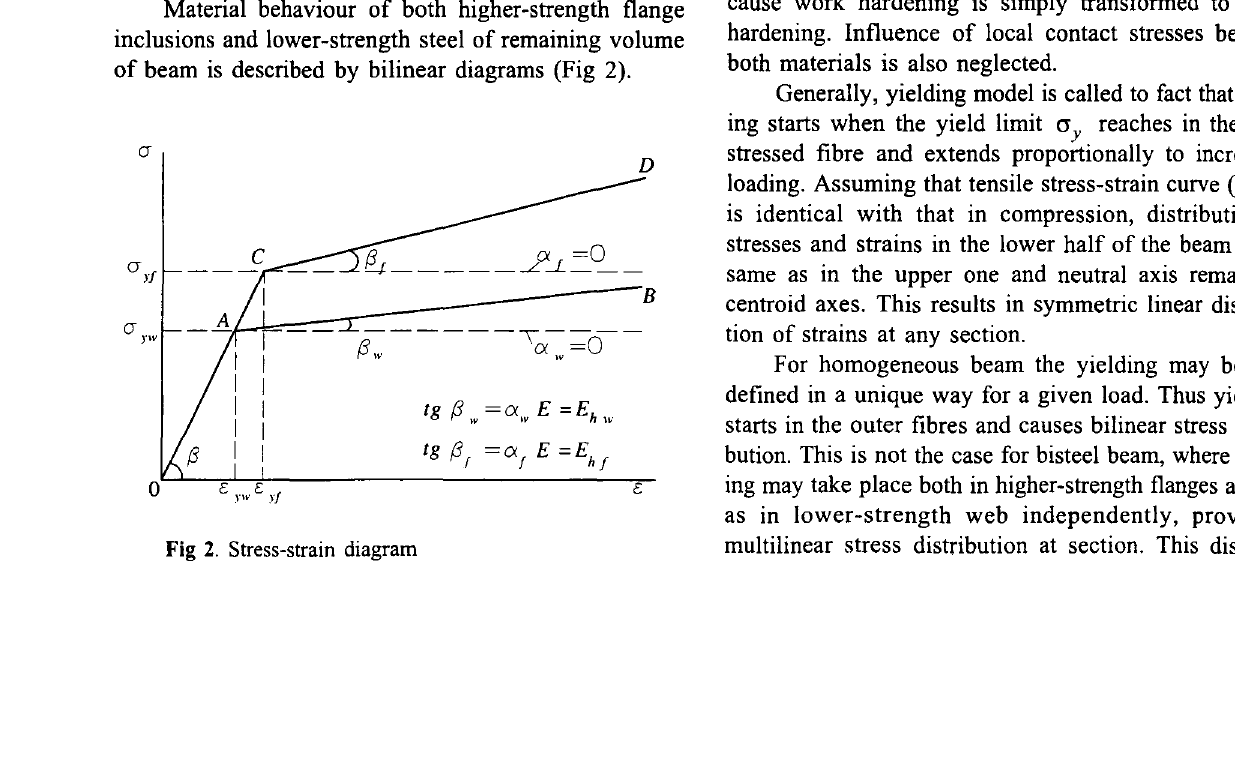
Fig 1. I-section bisteel beam Since the bending moment diagram for simply sup ported beam by uniformly distributed load p is usual a parabola with the maximal value at the centre, the higher strength inclusions are constructed in the central part of the beam. The length of flange inclusions is denoted by line.